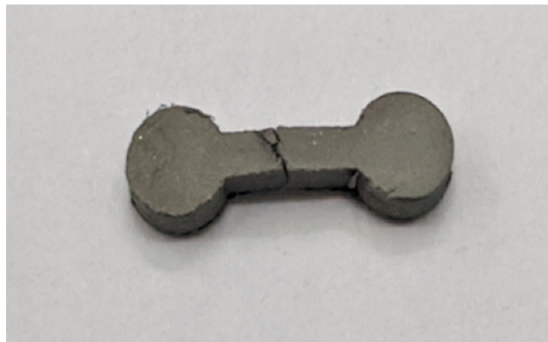
Figure 12. Mass loss of PS binder during solvent debinding from the micro-parts of ( a ) SS 17-4PH; and ( b ) 3YSZ.